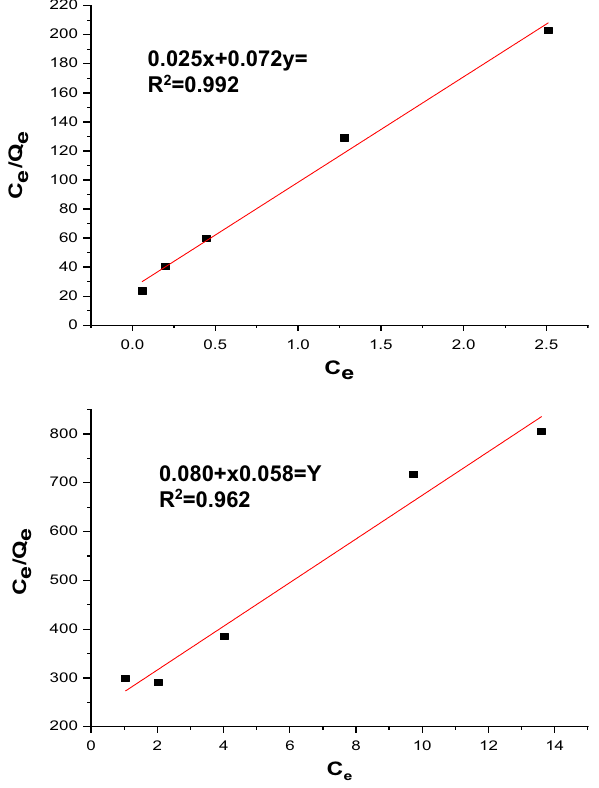
Figure 17. Langmuir ( a ) nano bentonite and ( b ) MgO impregnated clay plots for adsorption of MG.